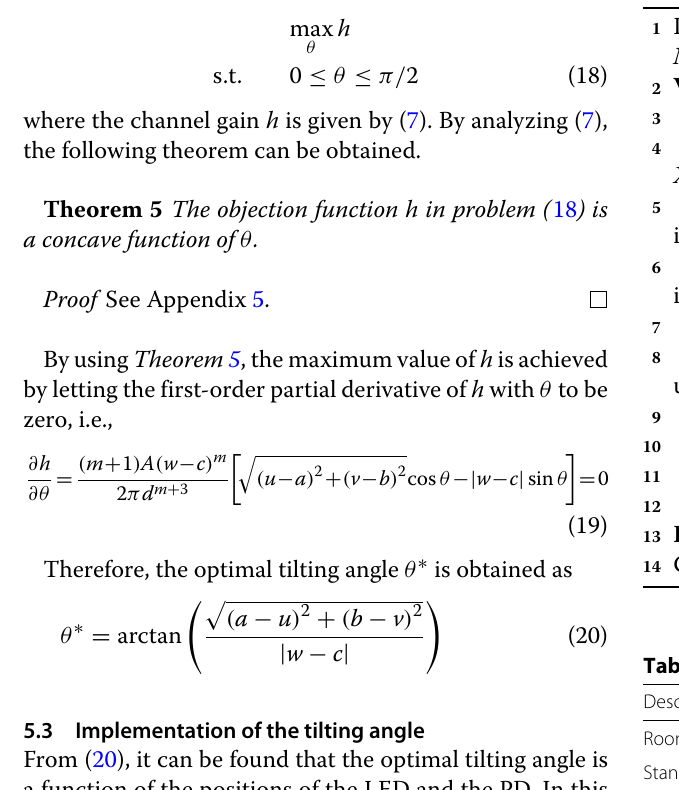
Algorithm 1: The simulation process for